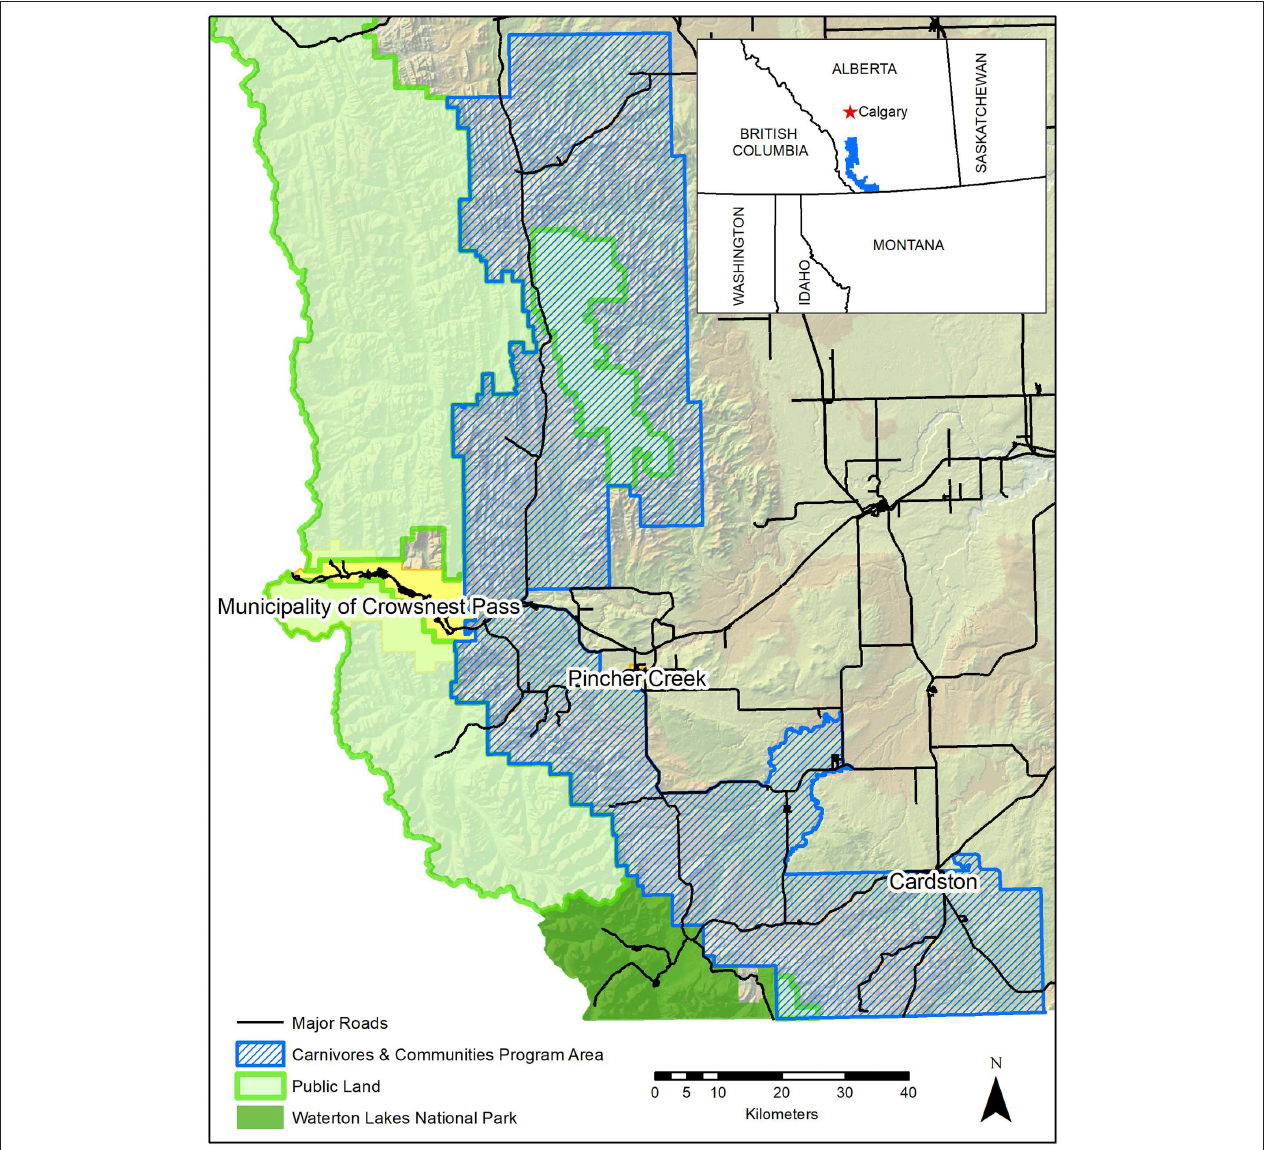
FIGURE 2 | The Waterton Biosphere Reserve’s Carnivores and Communities Program area in southwestern Alberta. Pictured are the towns of Pincher Creek, Cardston, and the Municipality of Crowsnest